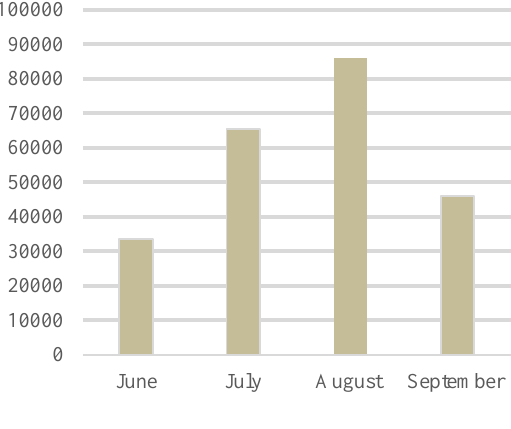
Figure 2. Number of visitors during the bathing season in